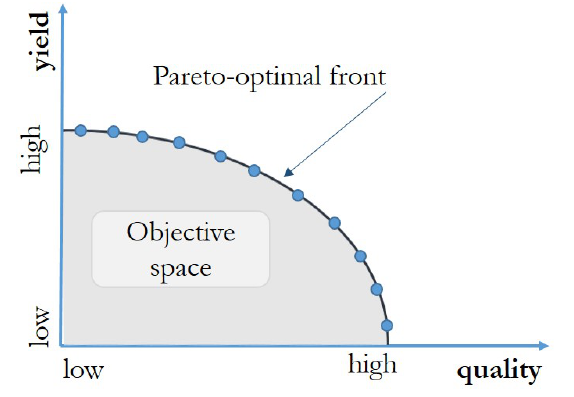
Figure 1. Optimal solutions of the function J for different weights ( w 1 and w 2